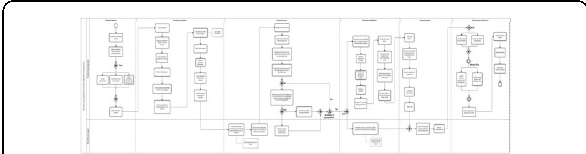
Fig. 1 (abstract 001091). Final Model After Delphi Panel of